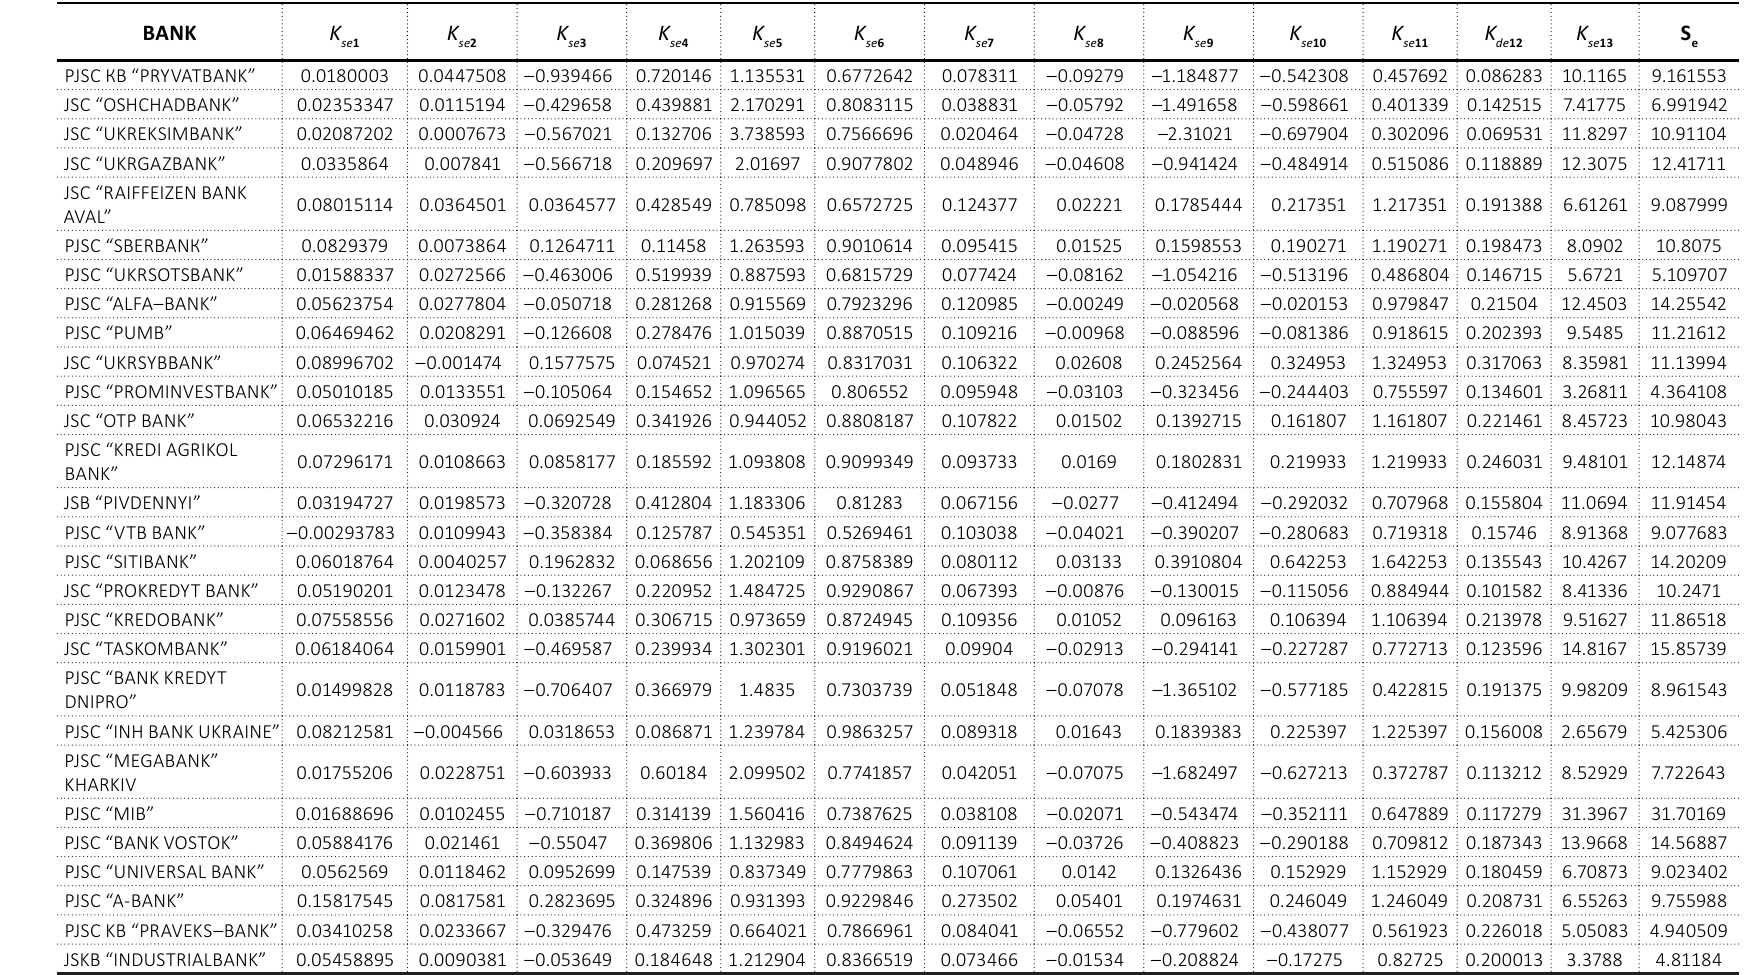
group e Source: Calculated by the authors on the basis of banks’ financial reporting (National Bank of Ukraine,